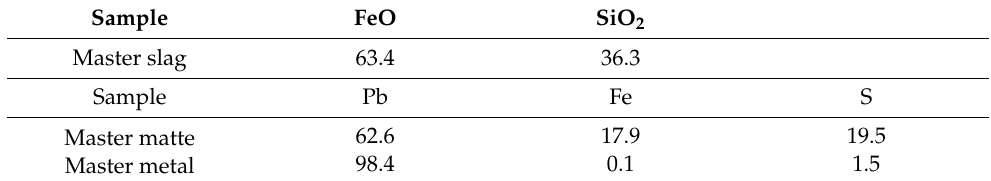
Table 1. Average compositions (wt.%) of the master slag and master matte measured by EPMA. Sample FeO Master